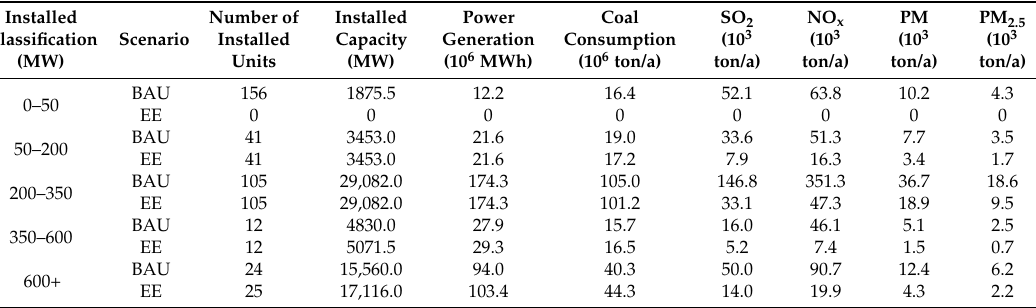
Table 3. Scenario analysis results.